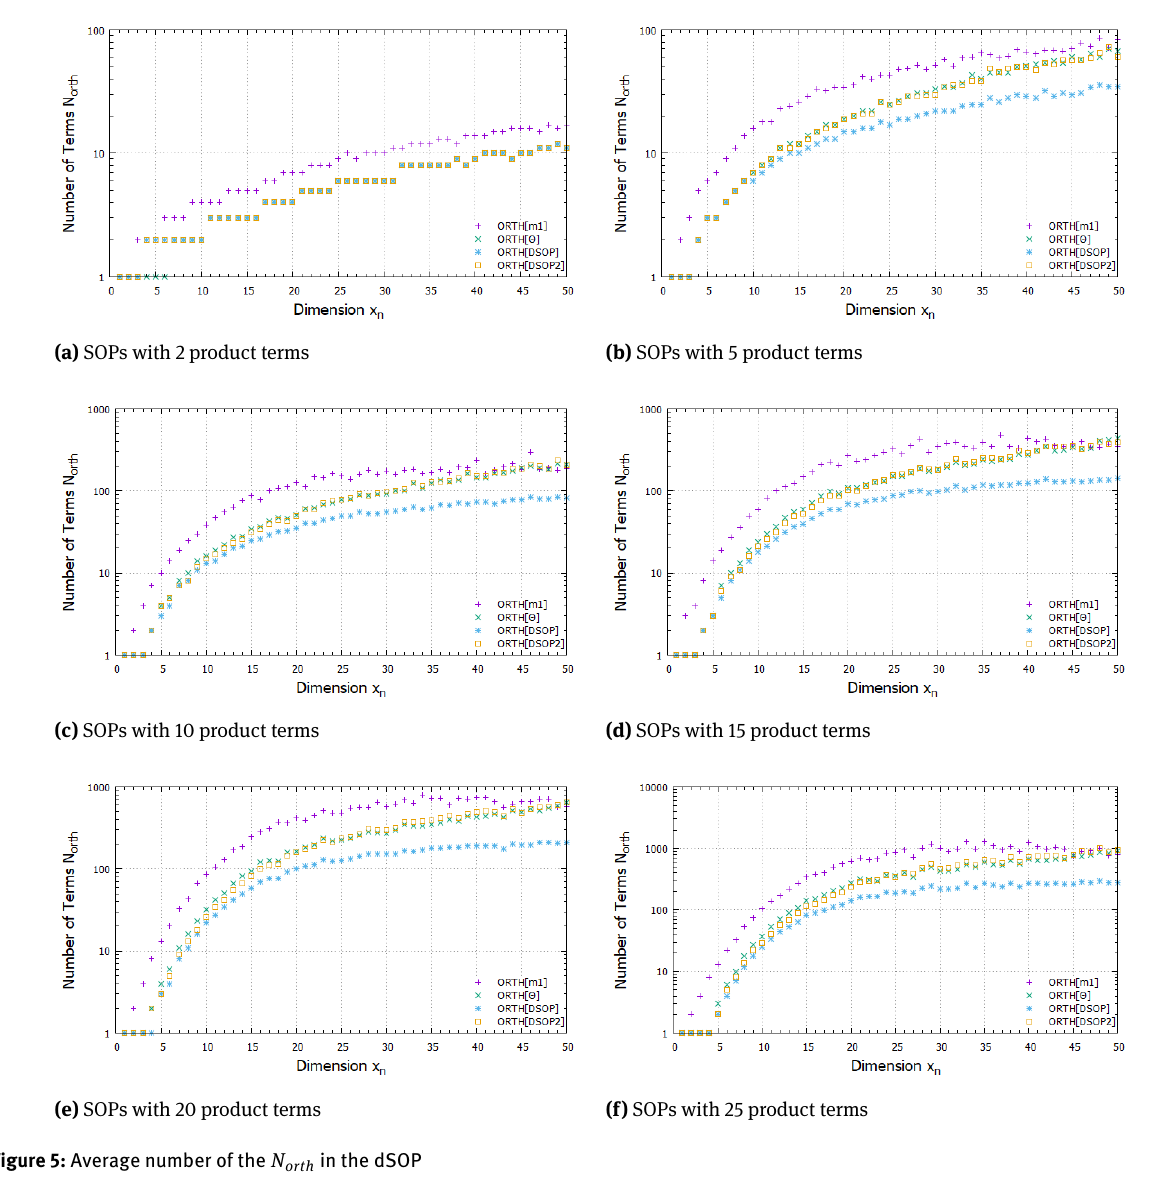
Figure 5: Average number of the N orth in the dSOP